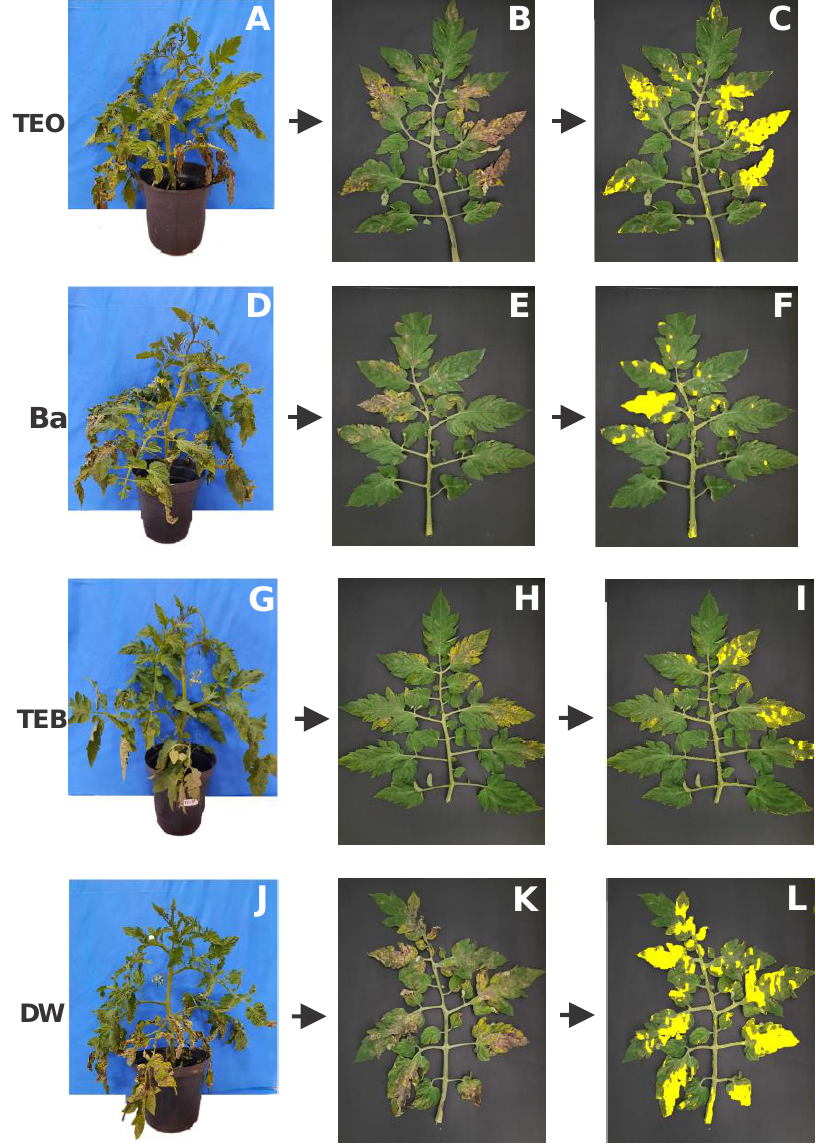
M Figure 4. Cont